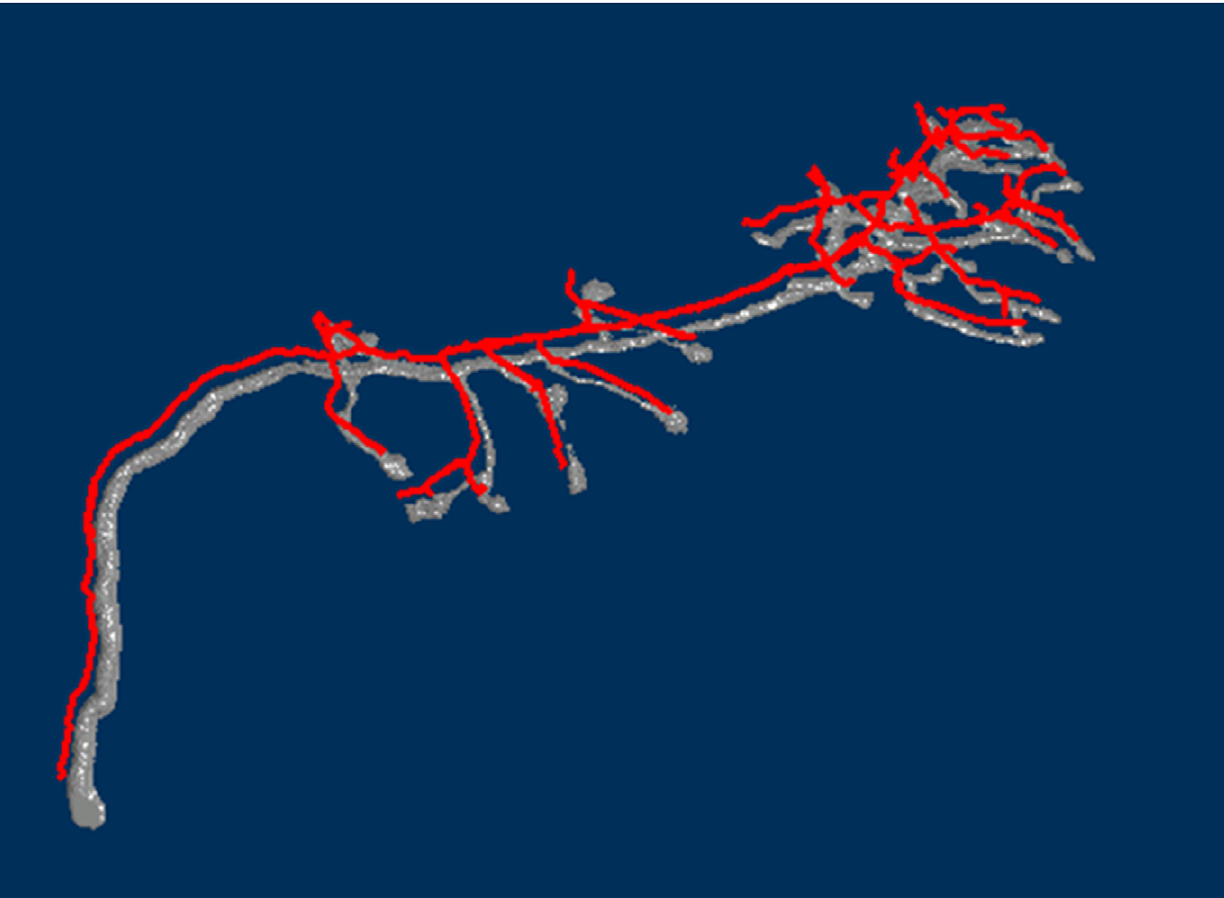
Figure 1. The rendered traced result ( red ) of a neuron overlaps with the volume rendering of the original image stack. For the purpose of comparison, the result is translated a little from its original position.